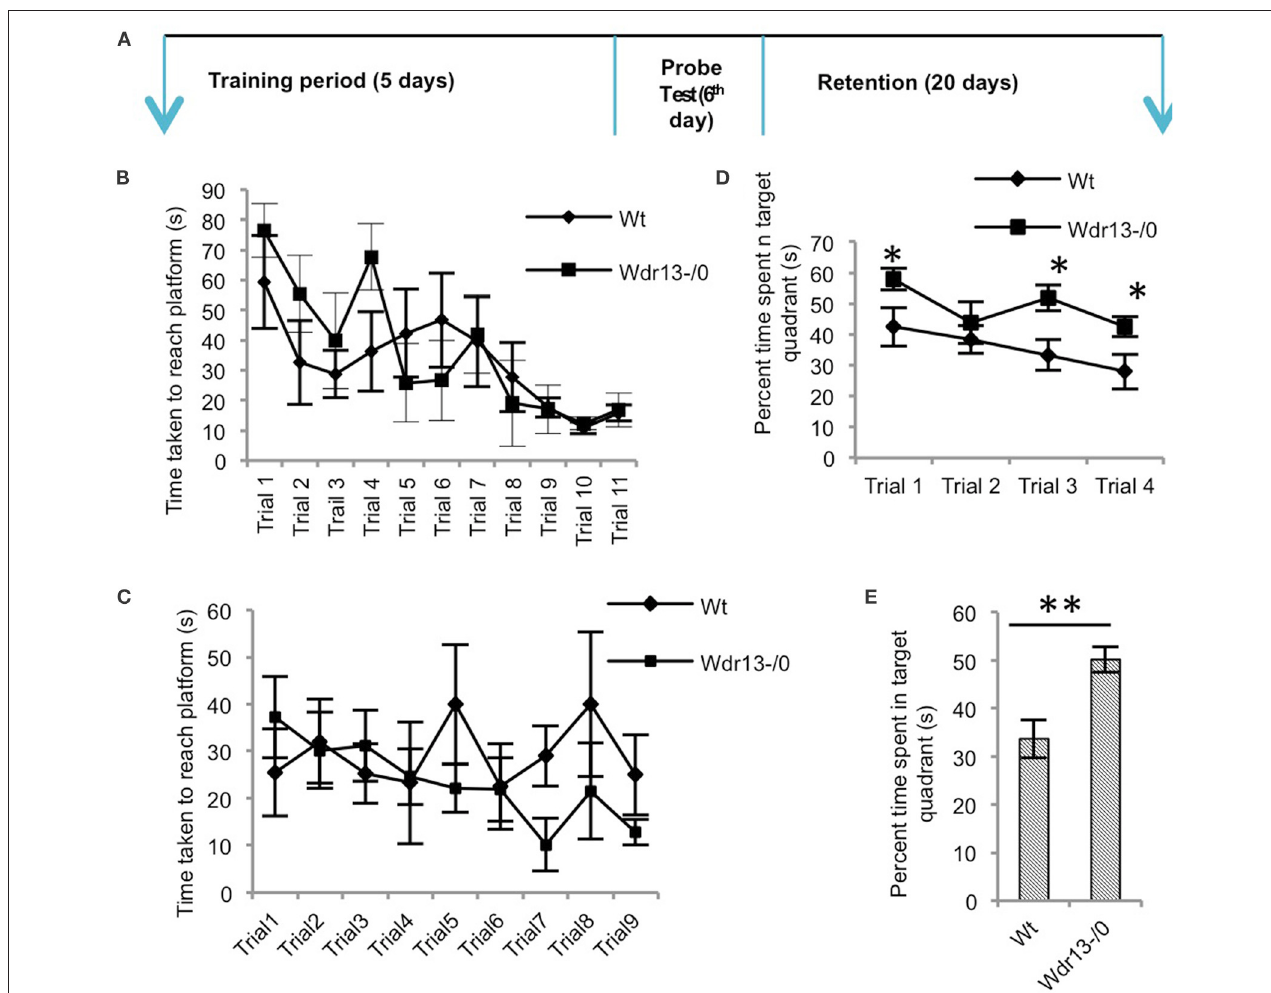
FIGURE 4 | The Morris water learning and memory test. (A) Schematic of the protocol followed for the experiments. (B) There was no significant difference (ANOVA; p > 0.05) between Wdr13 − / 0 and the wild-type mice in the latency (time) to reach the platform through the learning trials ( n = 6; Cohort 4). (C) Re-learning experiment showed no significant difference (ANOVA; p > 0.05) between the Wdr13 − / 0 and wild-type mice ( n = 6; Cohort 5). (D) On successive (extinction) probe trials, Wdr13 − / 0 mice spent significantly [ANOVA, F (1 , 40) = 14.24; p < 0.005] more time in the target quadrant as compared to the wild-type mice ( n = 6; Cohort 4). (E) Wdr13 − / 0 mice showed better long-term memory by spending significantly ( T -test; p < 0.005) more time in the target quadrant when subjected to probe trial after 20 days of learning phase ( n = 6; Cohort 6). Data represented as ± SEM. Wt, wild-type; Wdr13 − / 0 , Wdr13 knockout mice. * p < 0.05, ** p < 0.005.